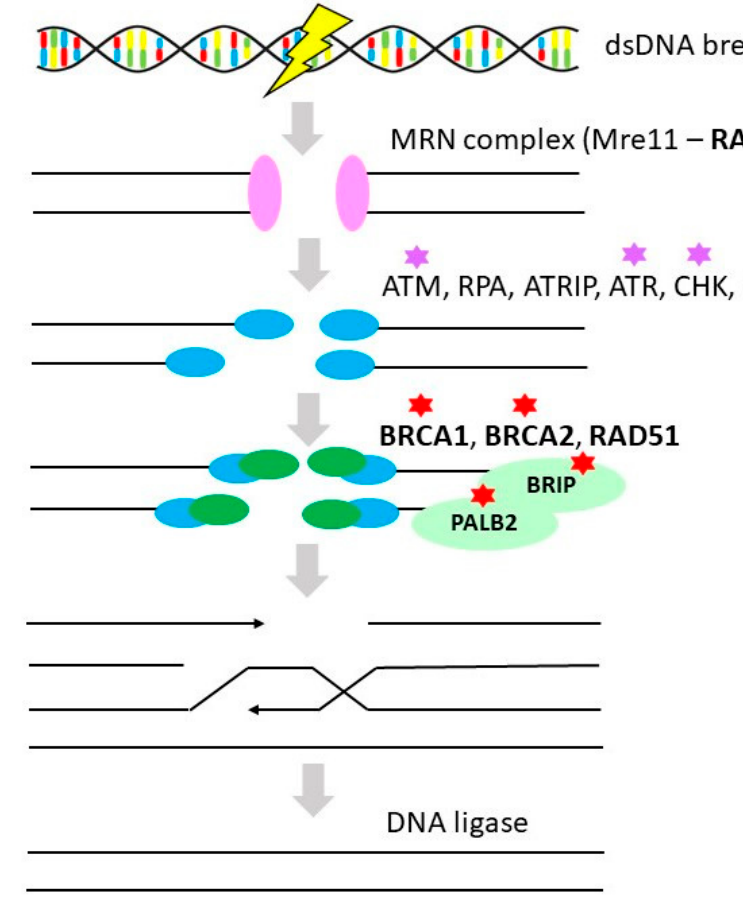
Figure 2. Homologous recombination. Simplified scheme of homologous recombination in double-strand DNA breaks and DNA inter-strand crosslinks (gene alternations in OvC in bold , therapeutic interventions considered in OvC therapy marked by a red star (PARP inhibitors), purple star (check-point inhibitors)) [43]. Protein names: meiotic recombination 11 (MRE11), RAD50 homolog (RAD50), Nijmegen breakage syndrome 1 (NBS1), Ataxia telangiectasia mutated (ATM), replication protein A (RPA), Ataxia telangiectasia and RAD3 related-interacting protein (ATRIP), Ataxia telangiectasia and RAD3 related (ATR), checkpoint kinases (CHEK), retinoblastoma binding protein 8 (CtIP), breast cancer 1 and 2 (BRCA1 and 2), RAD51 homolog 1 (RAD51), BRCA1-interacting protein C-terminal helicase (BRIP1), partner and localizer of BRCA2 (PALB2) [44].